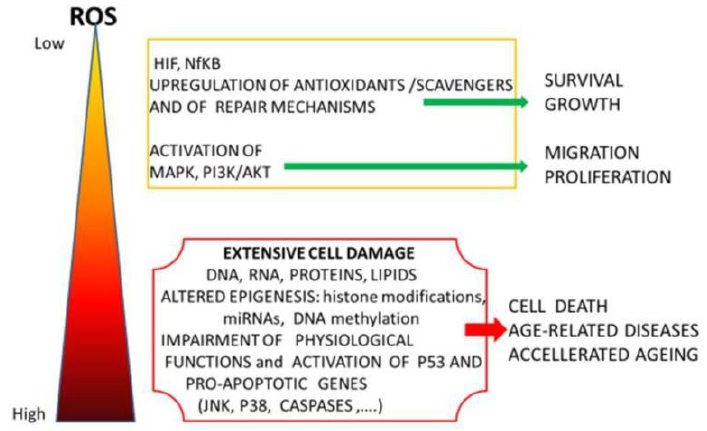
Figure 3. Schematic representation of cellular effects of various reactive oxygen species (ROS) levels. While low levels stimulate cell recovery/survival, high levels alter epigenetic mechanisms and induce degenerative processes or apoptosis via activation of p53 and pro-apoptotic genes. HIF (Hypoxia inducible factor) and NfKB (nuclear factor kappa light-chain-enhancer of activated B cells) are both involved in inflammation response, MAPK and PI3K/AKT (phosphatidylinositol 3-kinases/protein kinase B). are major regulators of cell cycle and survival and JNK (c-Jun N-terminal kinase) and P38 are key mediators of oxidative stress often associated with apoptosis and increased caspase activity.